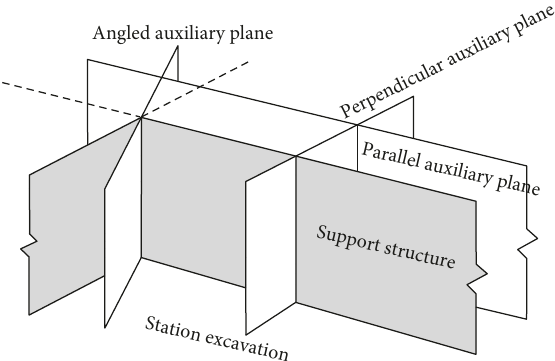
Figure 1: Auxiliary planes around station